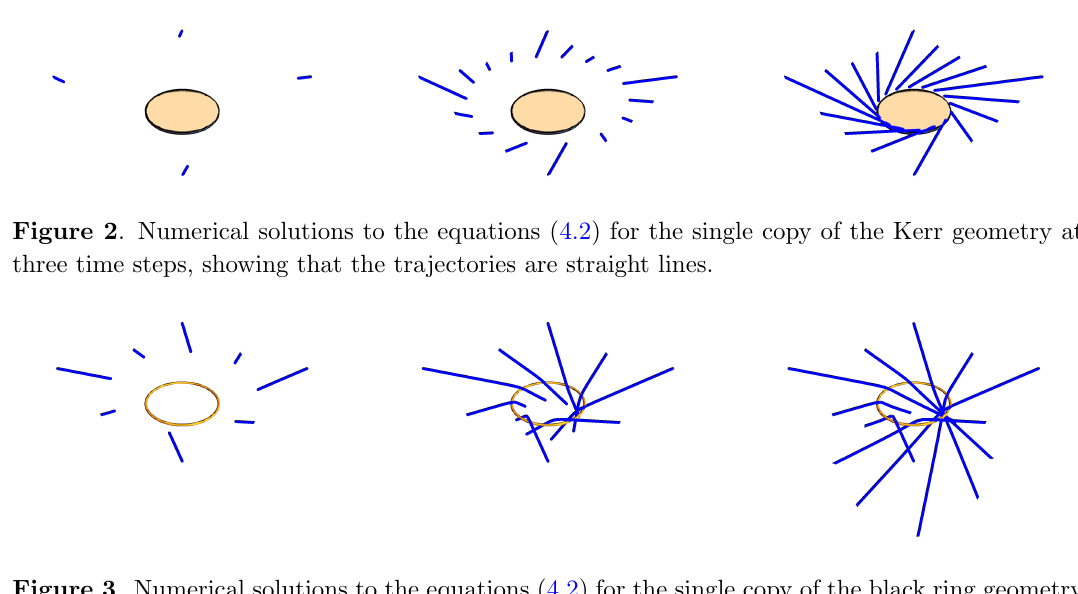
Figure 3 . Numerical solutions to the equations (4.2) for the single copy of the black ring geometry at three time steps. Scattering in the vicinity of the ring shows that the gauge current does not admit a null geodesic gauge